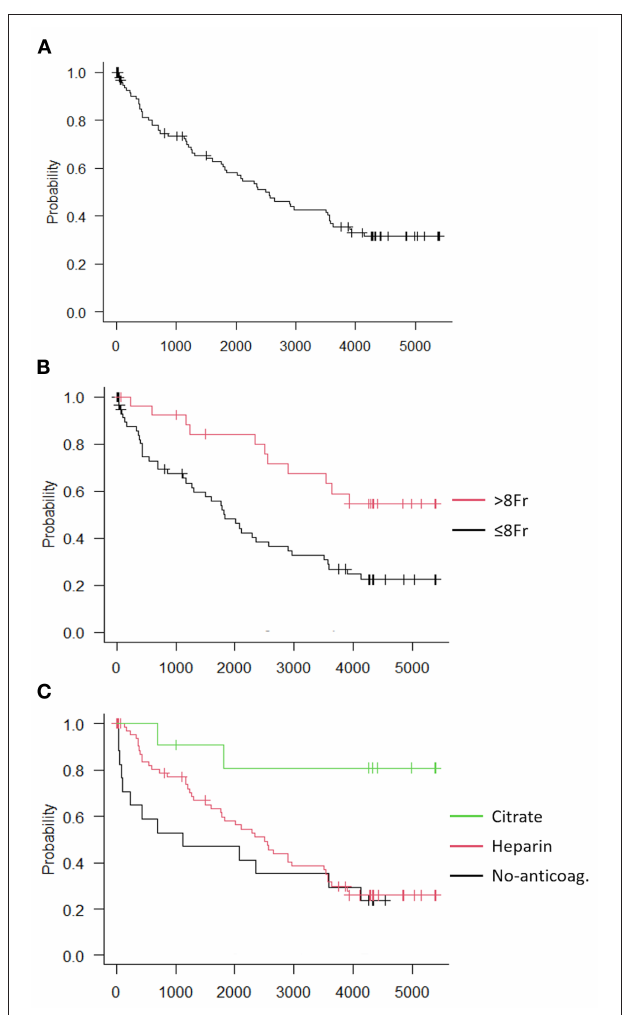
FIGURE 1 | Kaplan-Meier curves of session-related clotting independent risk factors. (A) Clotting-free survival analysis of all 101 sessions, (B) Sessions divided according to vascular access caliber, (C) Sessions divided according to anticoagulation